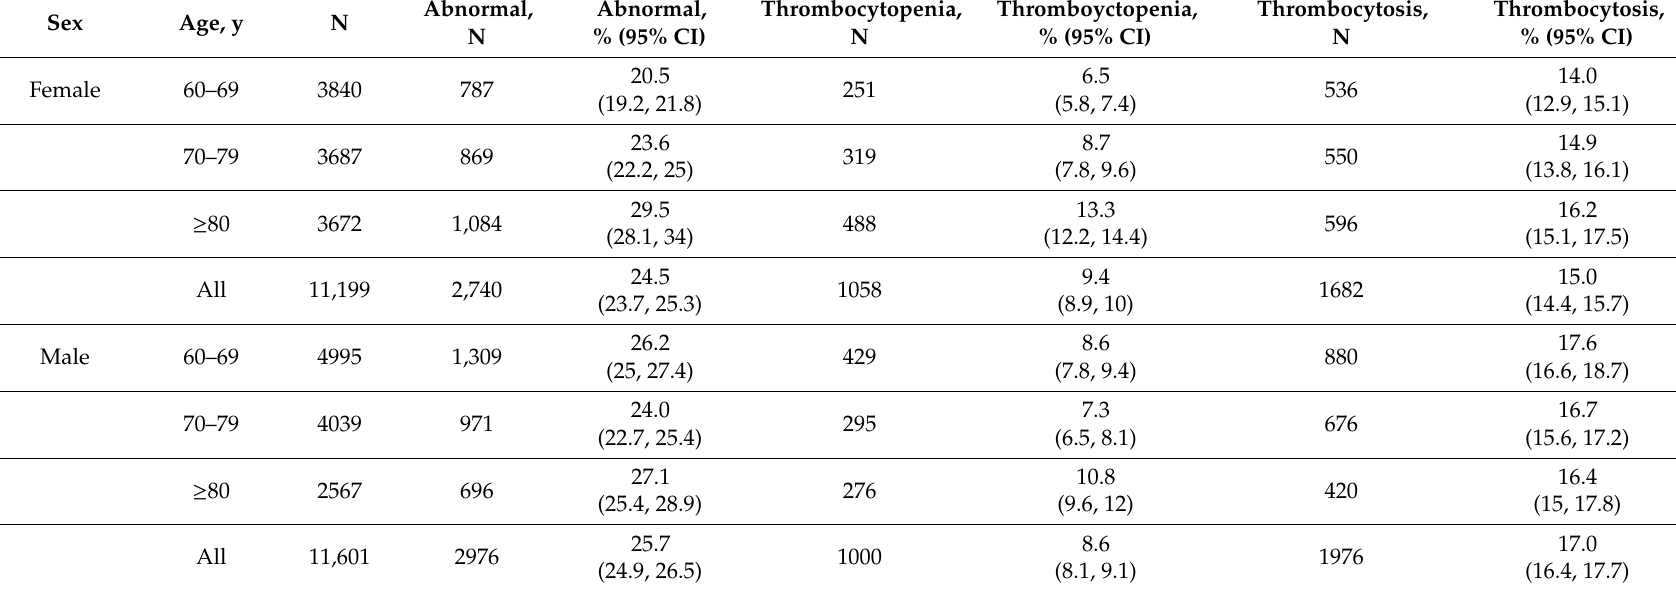
Table 5. Frequencies of abnormal platelet counts in a population-based setting in the Principality of Liechtenstein, applying sex- and age-dependent reference intervals for males as evaluated in the present